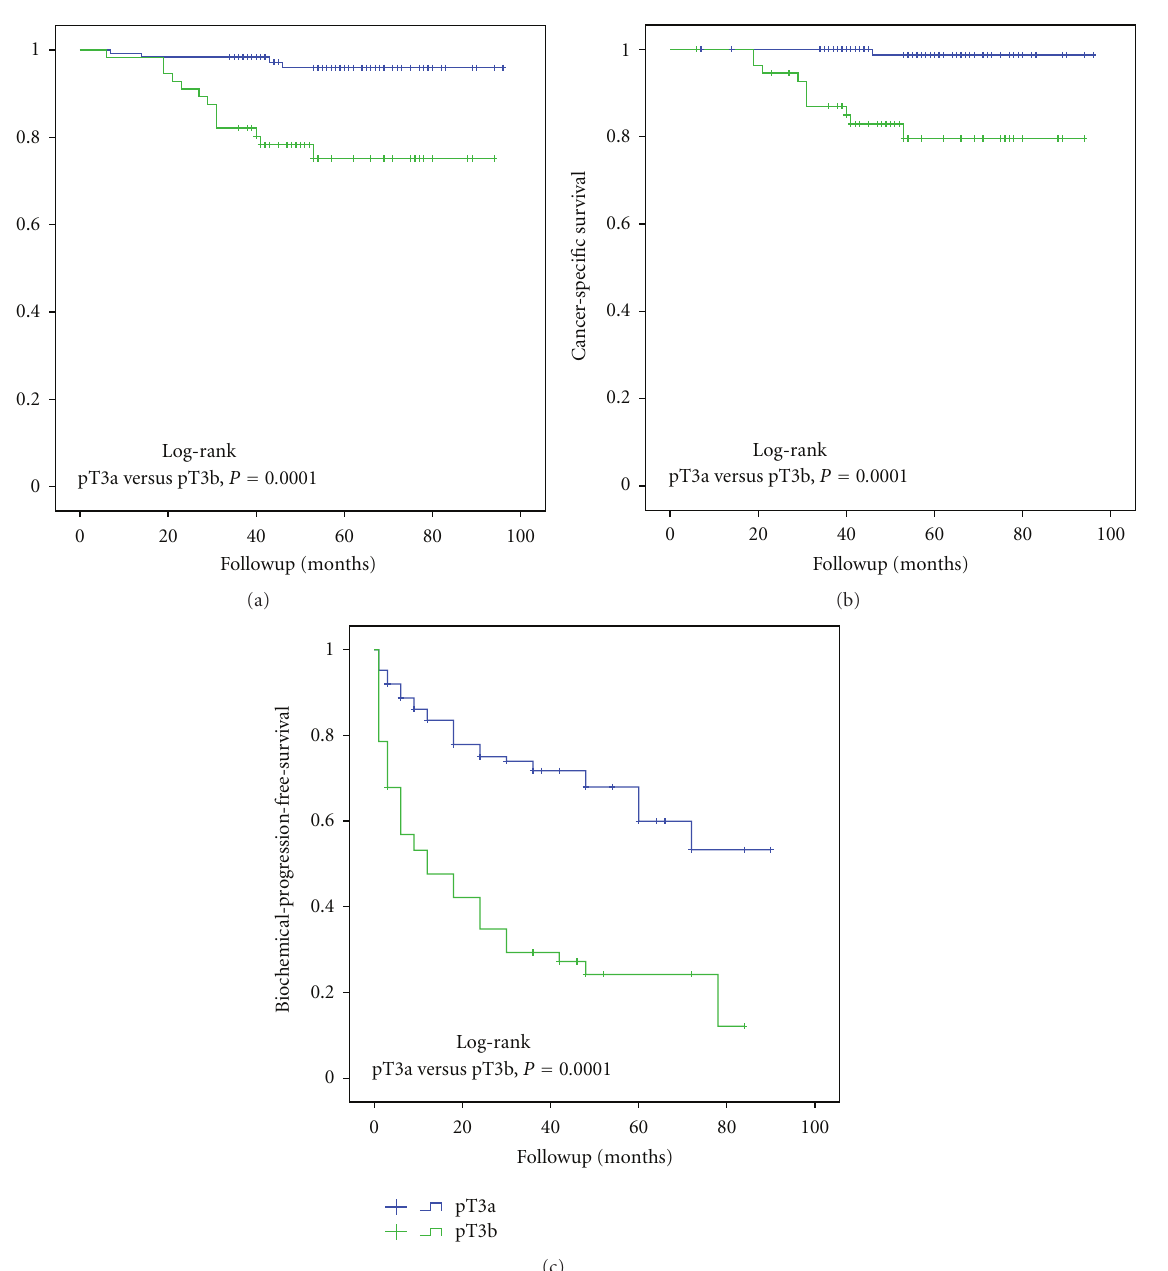
combination group: 78% and 94%, respectively. Our study data showed a comparable 94% 5-year CSS, similar to RT and ADT combination